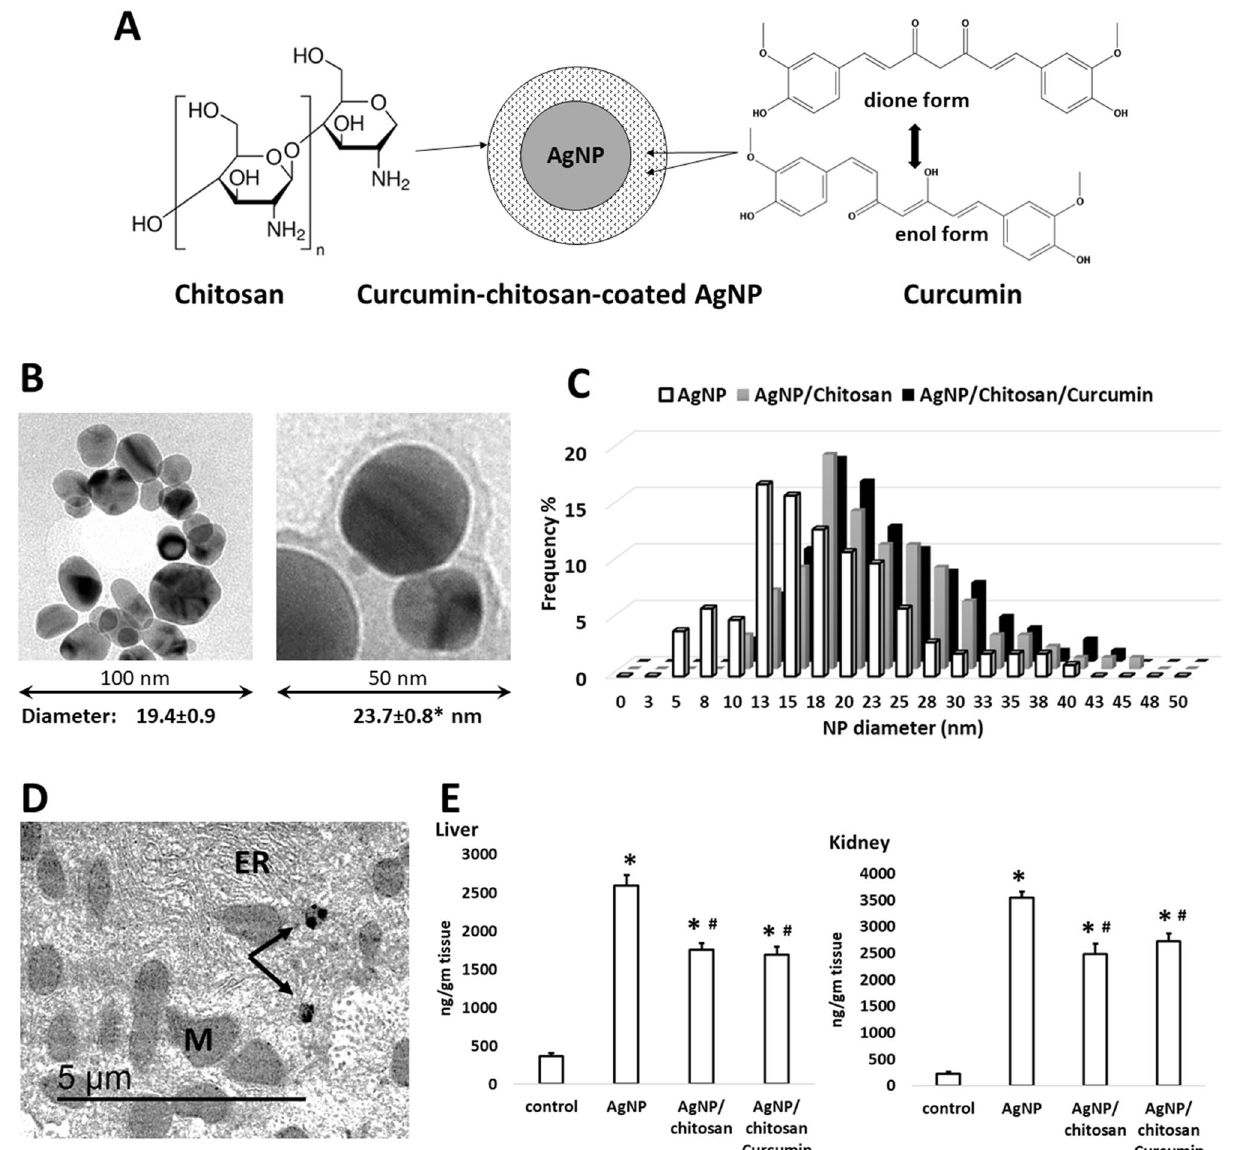
and curcumin. The left panel shows the chemical structure of chitosan, and the right panel shows the chemical structure of both curcumin forms. ( B ) transmission electron microscopy (TEM) of non-coated (left) and coated (right) AgNPs. The diameter is expressed as mean ± SEM of n = 100 measured NP diameters. The * denotes significant difference in diameter between non-coated and coated AgNPs (t-test). ( C ) the diameter of most non-coated AgNPs ranged between 12.5 and 22.5 nm, while that of coated NPs peaked at 17.5–20 nm. ( D ) intrahepatocyte detection of AgNPs (arrows) by TEM of a liver from AgNP-treated mouse. ER, endoplasmic reticulum; M, mitochondria. ( E ) estimation of Ag content in livers and kidneys of mice treated with coated or non-coated AgNPs. Statistical analysis: ANOVA P < 0.05; * = significantly higher than the control values; # = significantly lower value of silver content (posthoc t-test after